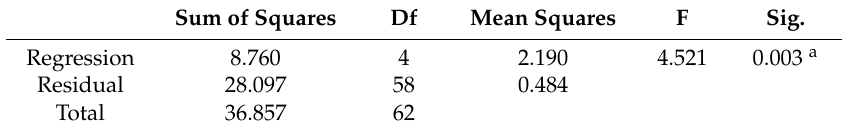
Table 5. The regression analysis of the factors on the originality evaluation by students. Sum of Squares Df Mean Squares F Sig.